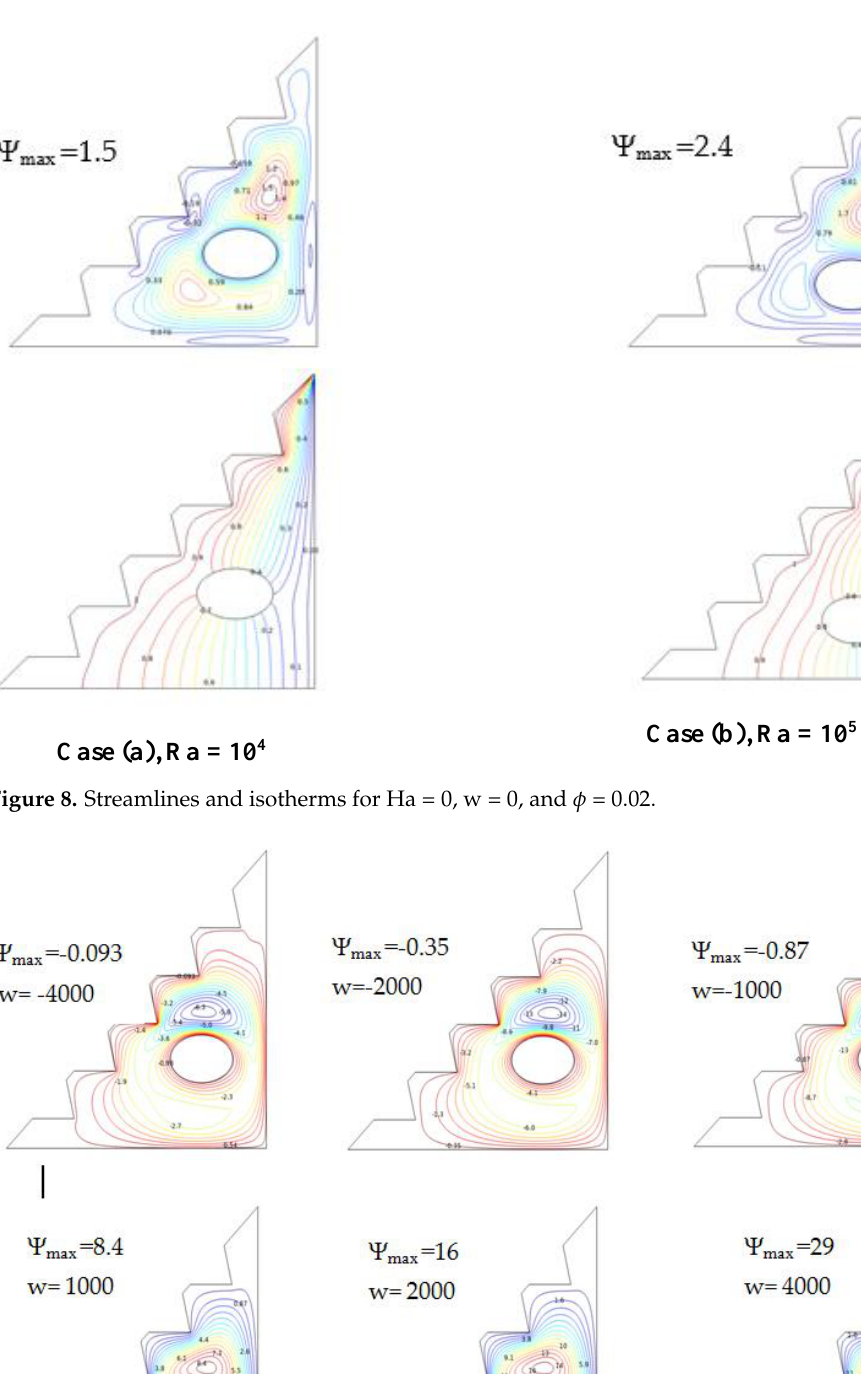
Figure 9. Streamlines via w and Ra = 10 5 , ϕ = 0.04, and Ha = 0.